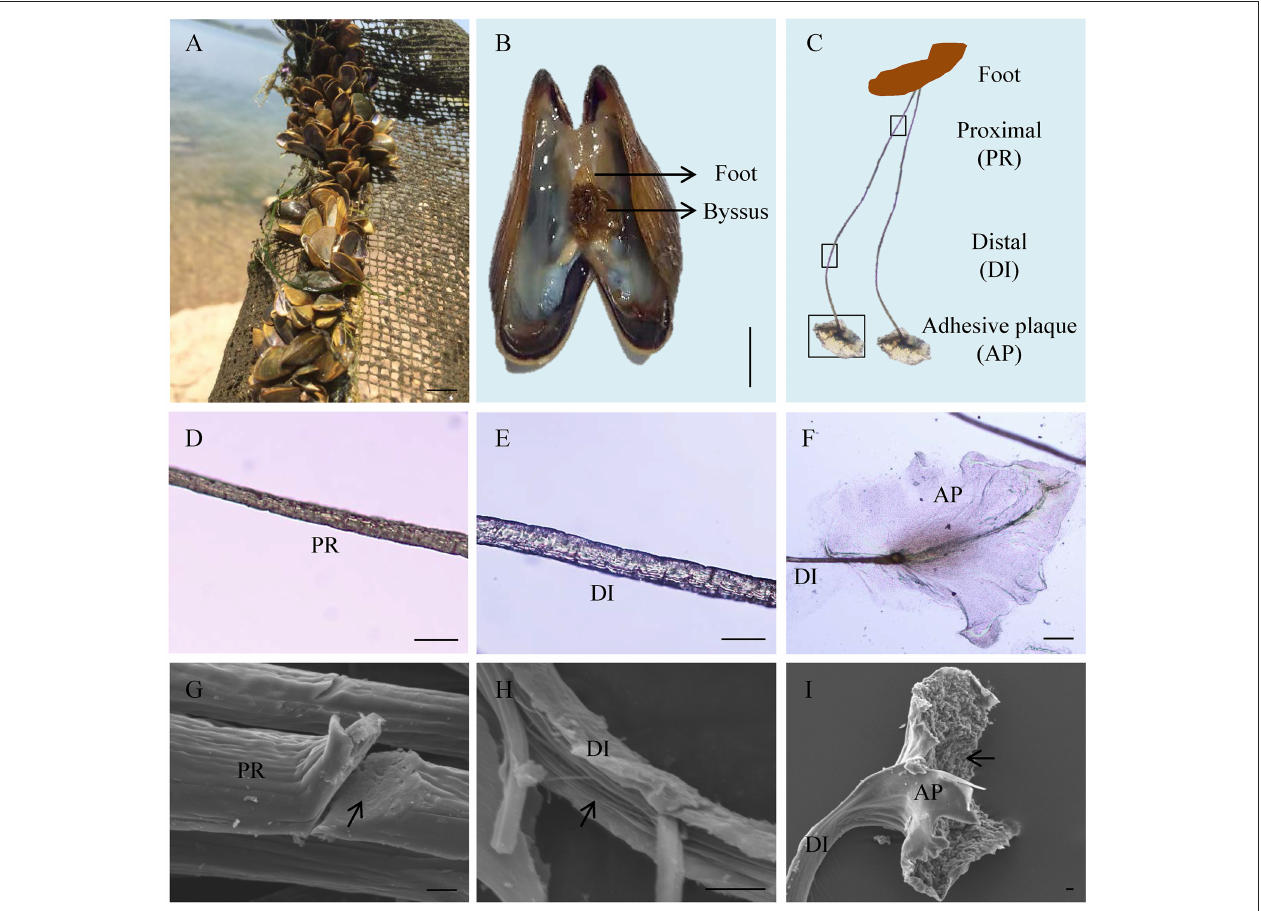
FIGURE 1 | Byssus morphology and structure of the golden mussel Limnoperna fortunei. (A) L. fortunei living in natural freshwater. (B) Photograph showing the position and morphology of foot and byssus. (C) The structure of byssal threads. PR, Proximal thread; DI, Distal thread; AP, Adhesive plaque. The black boxes indicate the observation regions for (D–F) . (D) Light photograph for the PR region. (E) Light photograph for the DI region. (F) Light photograph for the AP region. (G) Scanning electron micrograph for the PR region. The arrow indicates the compact ultrastructure of PR. (H) Scanning electron micrograph for the DI region. The arrow indicates the fibroid ultrastructure of DI. (I) Scanning electron micrograph for the AP region. The arrow indicates the rough underside of AP facing to substratum. Bar scale is 1cm in (A,B) , 50 µ m in (D–F) , and 10 µ m in (G–I)